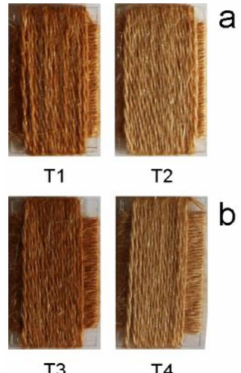
Figure 1. Wool yarn dyed with different percentage of onion skin ( a : 100%, sample T1 and b : 75%, sample T3) with respect to the dry wool weight. Sample T2 and T4 were dyed in the residue bath previously used to dye samples T1 and T3, respectively.